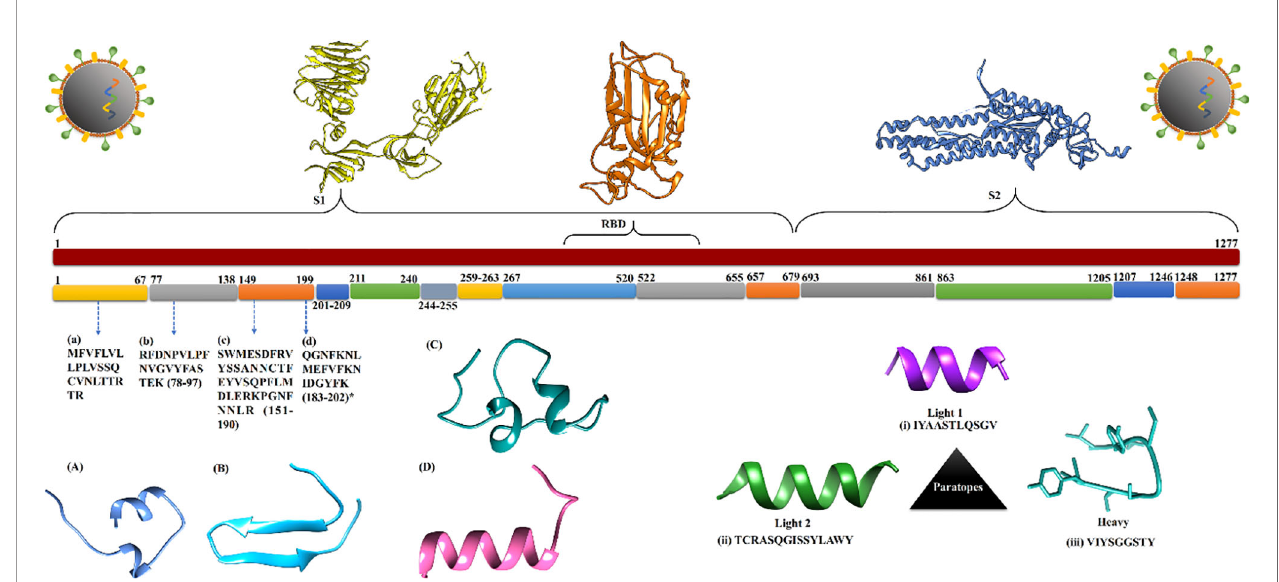
FIGURE 2 | The conserved regions of spike protein extracted from protein data set of SARS-CoV-2. (A – D) Identi fi ed diagnostics peptide sequences with respect to their genomic location and 3D structure. (i – iii) Extracted paratopes sequence with their 3D